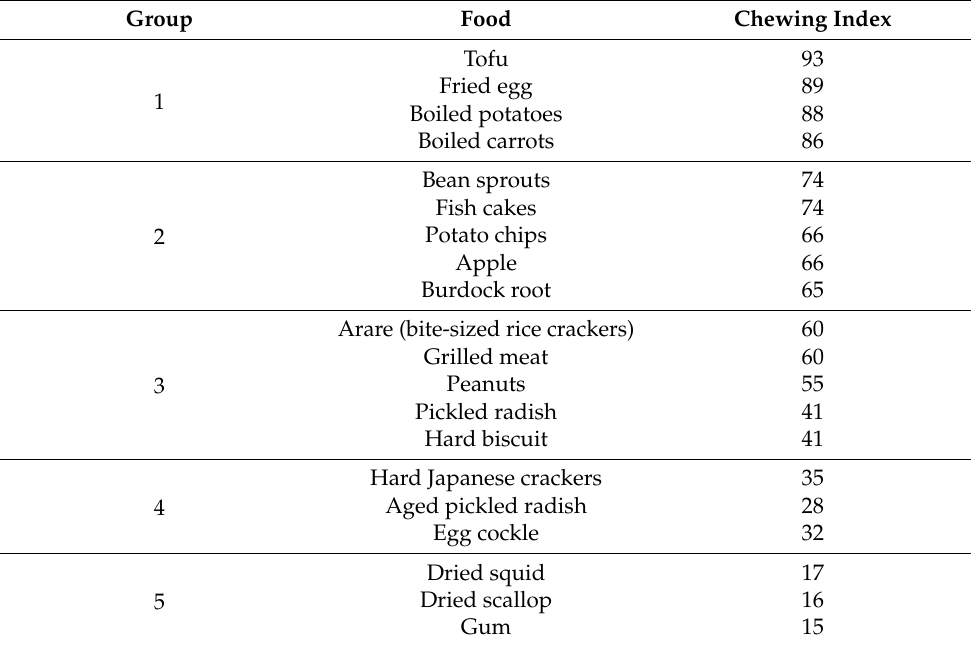
Table 1. Food acceptance score